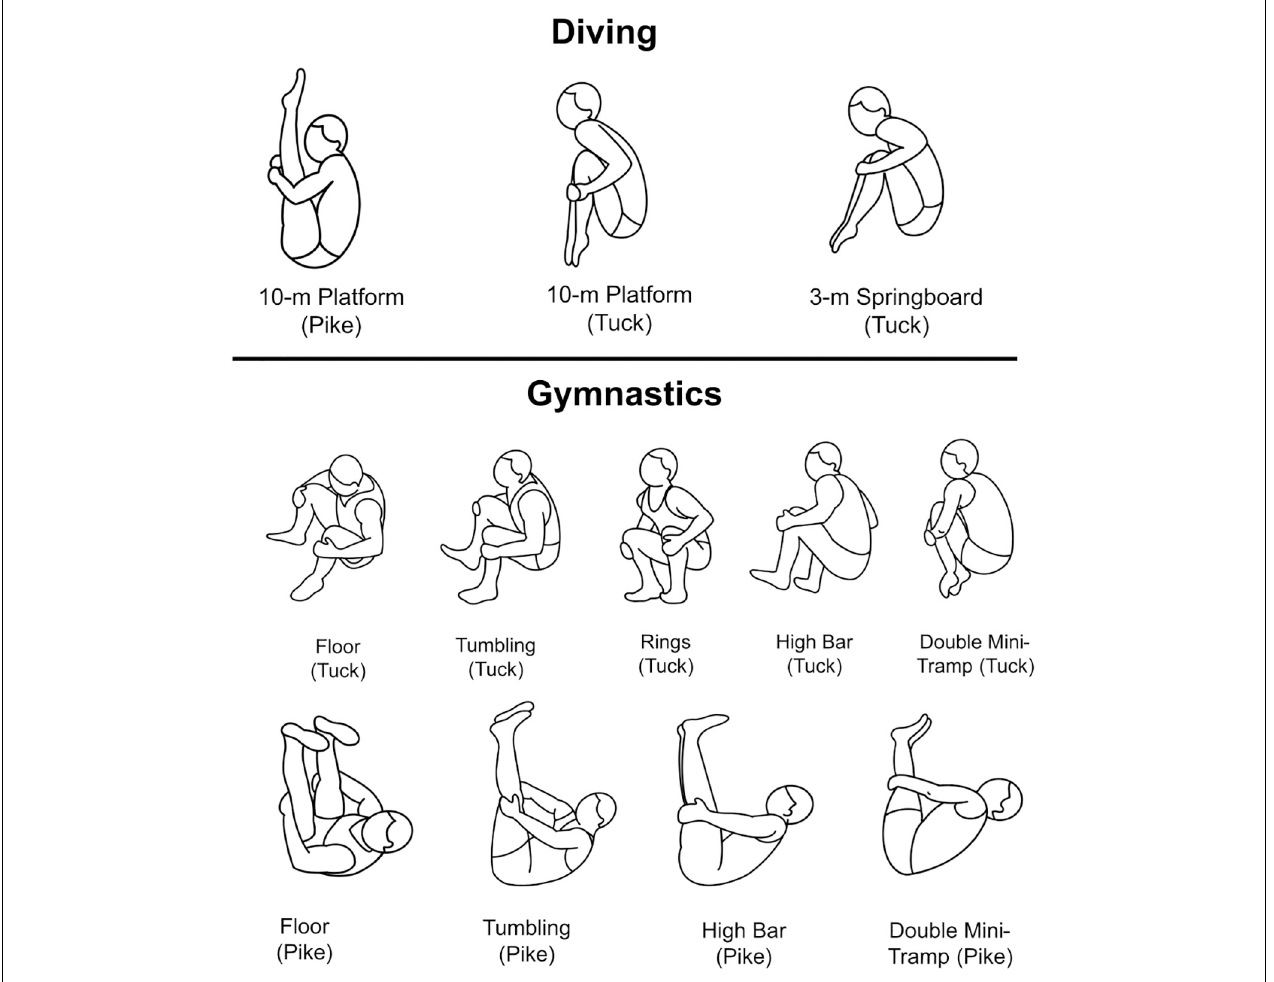
FIGURE 4 | Illustration of typical tuck and pike positions of divers and gymnastics during the tight and rigid somersaulting phase of 3.0 or 3.5 back somersaults at high-level